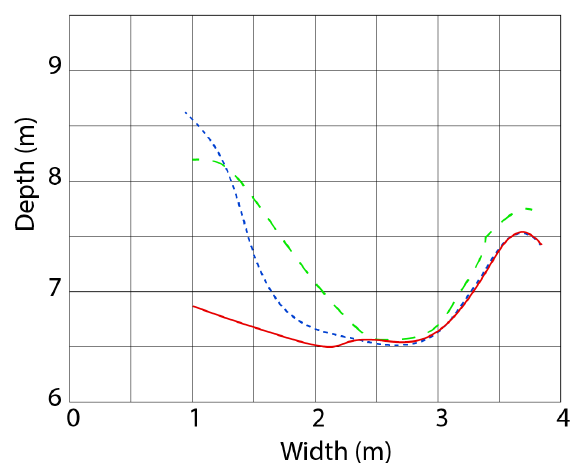
Figure 24. Estimated front lines of a pseudo static fire obtained at different instants: t = 92 s (green dashed line), t = 96 s (blue dashed line), and t = 100 s (solid red line).